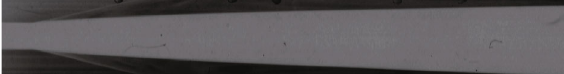
Figure 9: The wall-expanded negative in water